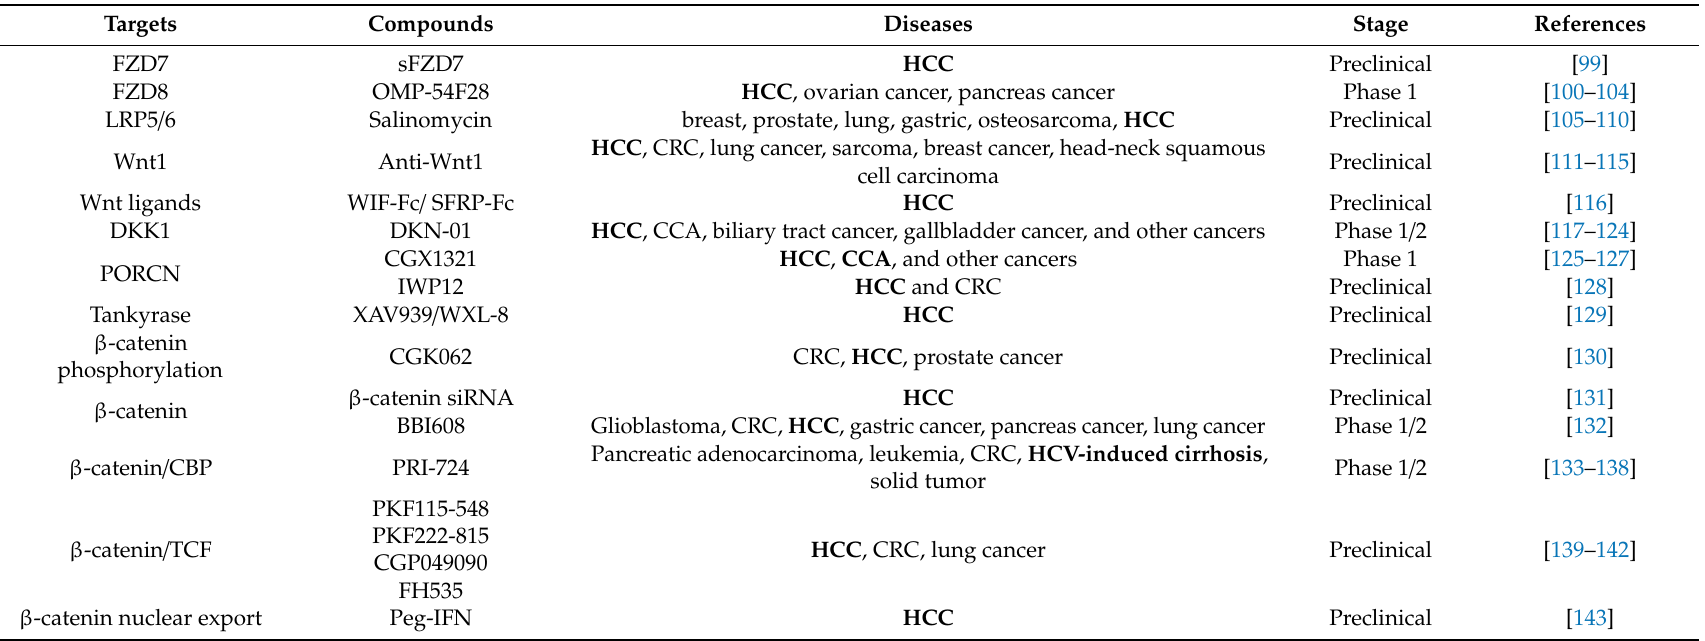
Table 2. Wnt / β -catenin signaling inhibitors undergoing preclinical and clinical evaluation in liver